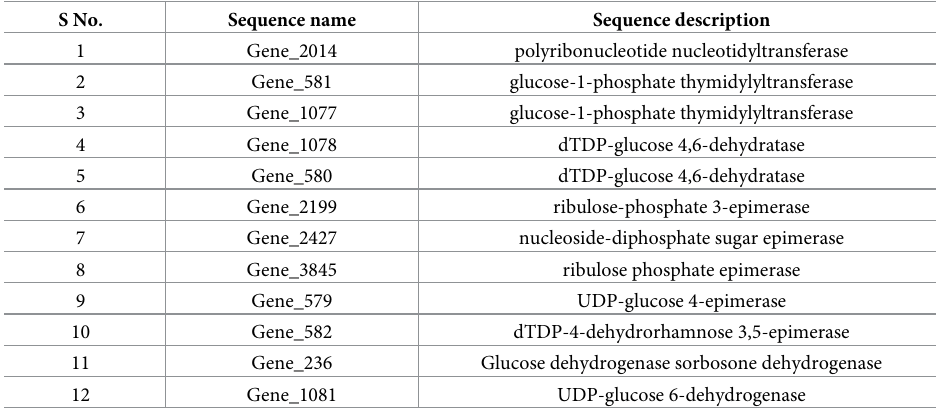
Table 3. Genes involved in biosynthesis of carbohydrate moiety.